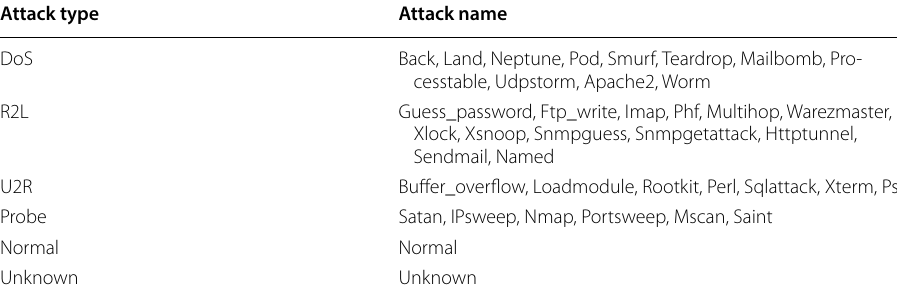
Table 4 Type of attacks available in NSL-KDD [3] Attack type